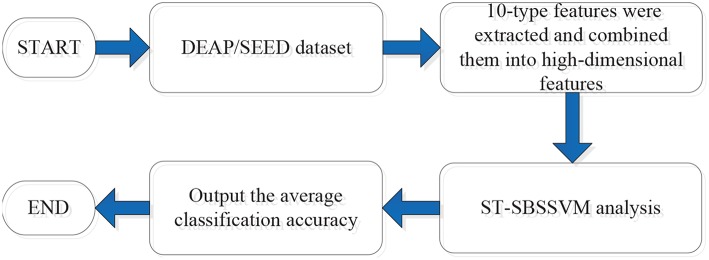
Analysis process.